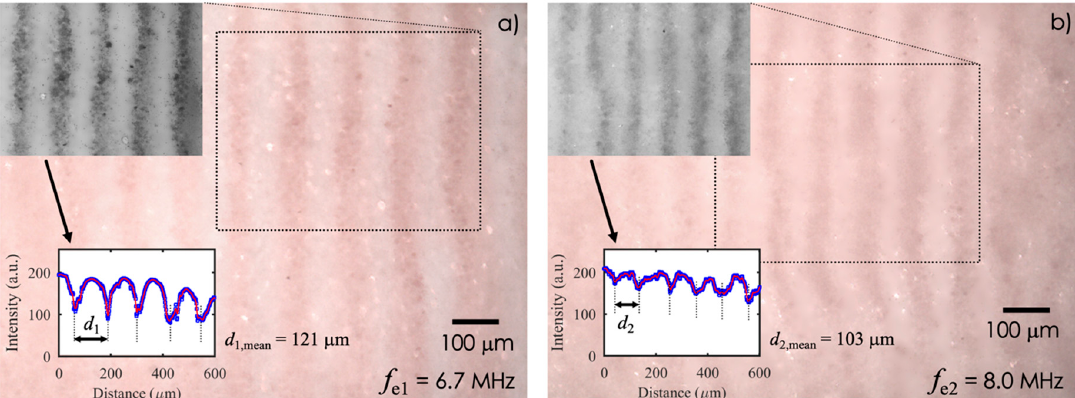
Figure 7. Effects of different wavelengths of acoustic waves on a human foreskin fibroblast (HFF) cell suspension. Cell accumulation in lines caused by the acoustic waves generated by exciting a single IDT at f e1 = 6.7 MHz ( a ) and f e2 = 8.0 MHz ( b ), respectively. The mean distances d 1,mean = 121 µ m and d 2,mean = 103 µ m have been estimated from the gray-scale intensity plots derived from the insets.